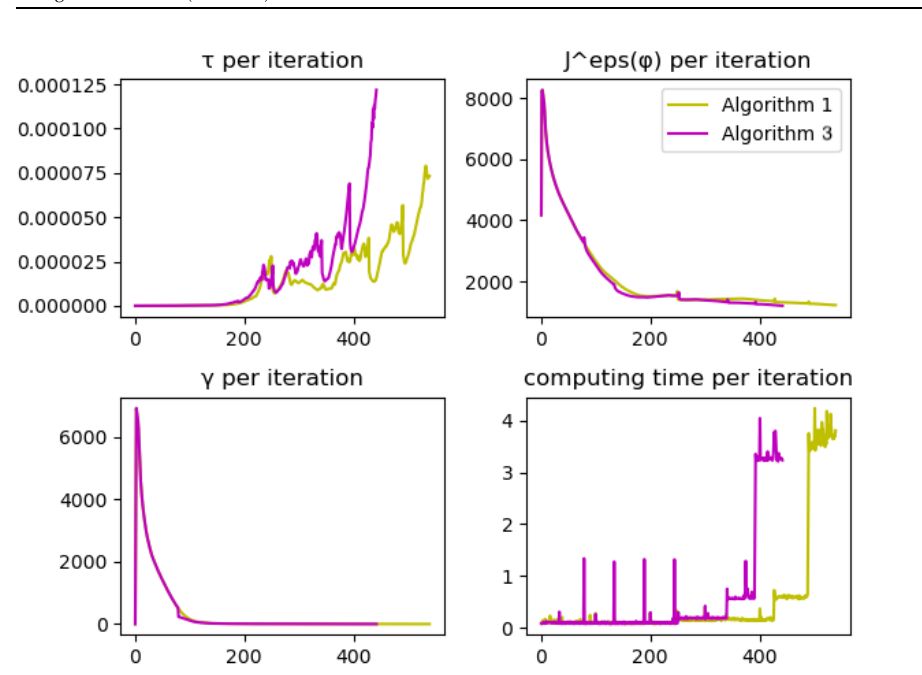
Figure 5. Comparison of metrics between Algorithms A1 and